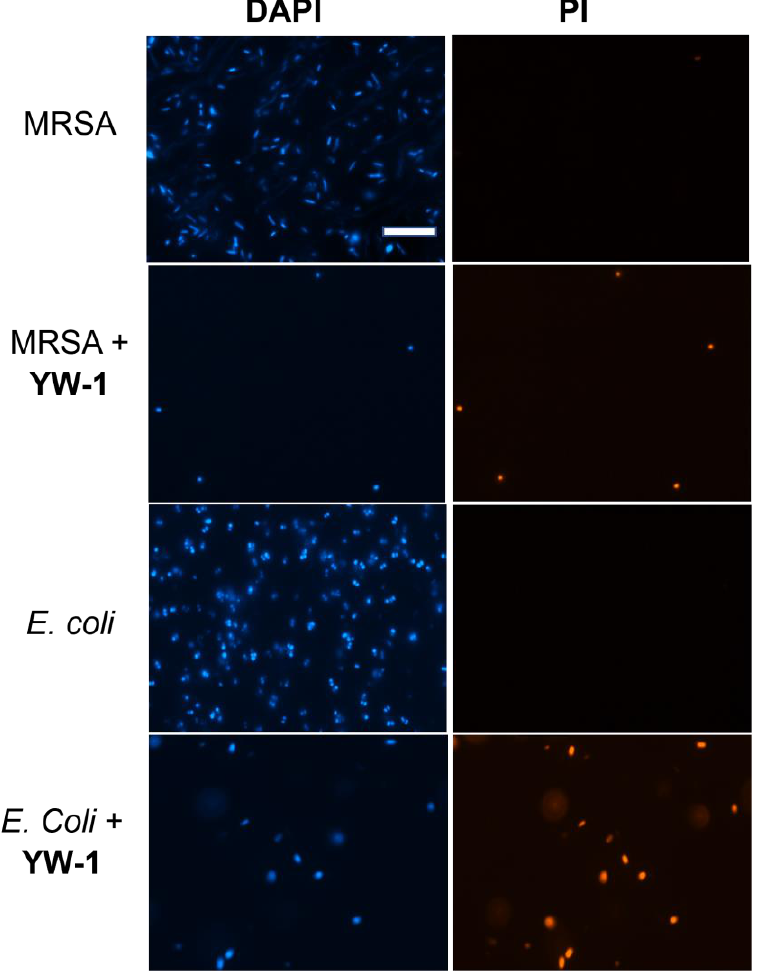
Figure 4. Fluorescence microscopy of the bacteria MRSA and E. coli treated with 2 × MIC of YW-1 , scale bar 10µm.